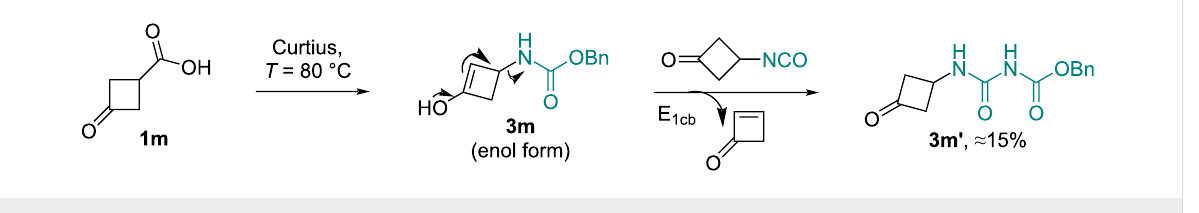
Scheme 2: Side reaction during formation of product 3m